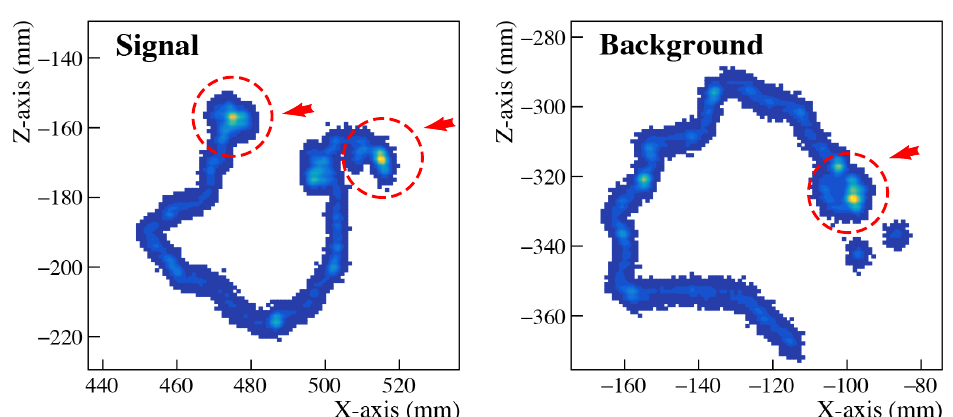
Figure 1. Projections in a 2-dimensional plane of a 0 νββ signal (left) and a background (right) event in a gaseous xenon TPC with 10 bar pressure and 1 mm pixels readout. The red dotted circles indicate the BBs. For the 0 νββ signal event two BBs can be seen at the ends while only one BB for the background